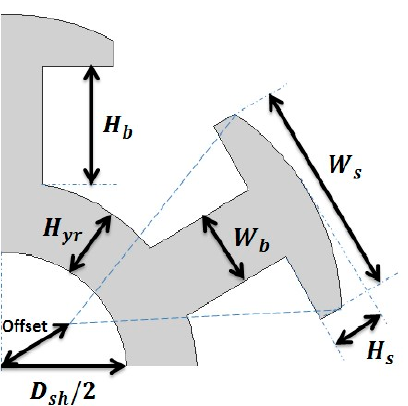
Figure 5. Dimension of salient pole rotor of the heptagonal based WRSM.